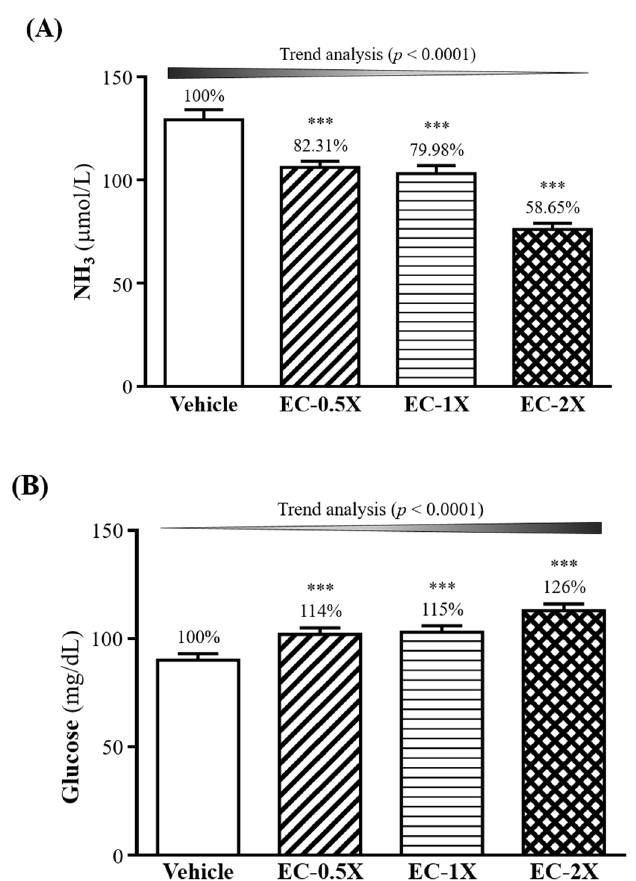
Figure 4. Effect of four-week EC supplementation on serum levels of ( A ) ammonia (NH 3 ) ( B ) glucose after a 10-min swim test. Ammonia level was measured immediately after 10 min swim test and glucose level was measured following 20 min rest after 10 min swim test. Mice were pretreated with the vehicle, EC-0.5X, EC-1X, and EC-2X for 28 days. Data is expressed as mean ± SEM, n = 10. Numbers above bars indicate percentage (%) change with vehicle control set as 100%. Significant difference from control group according to one-way ANOVA is indicated *** p < 0.001.